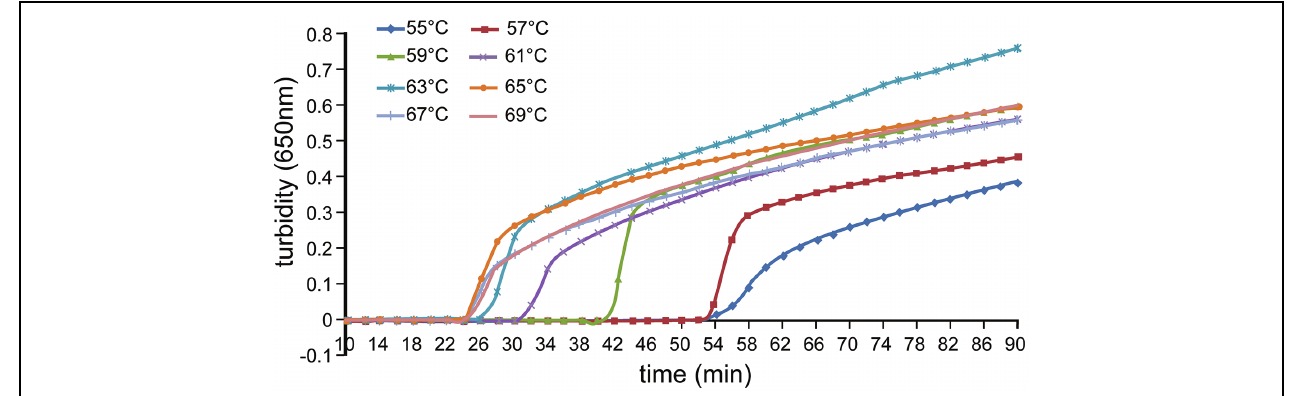
FIGURE 2 | Effect of differing temperatures on the efficiency of detection of A. baumannii by loop-mediated isothermal amplification (LAMP). Turbidity was monitored using a Loopamp real-time turbidimeter by measuring the absorbance at 650 nm every 6 s.